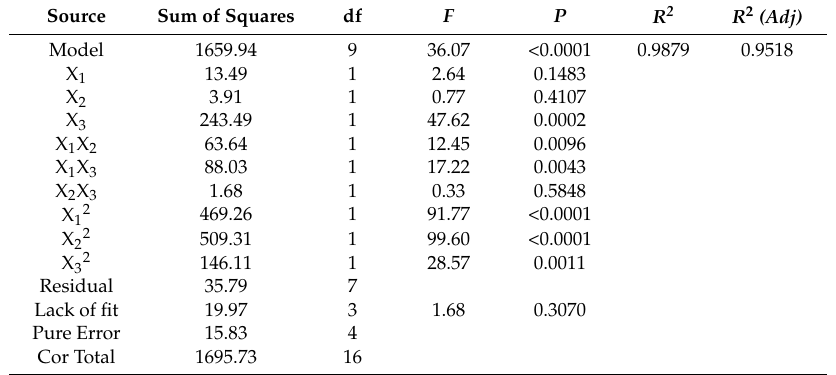
Table 2. ANOVA for the fitted quadratic polynomial model for IC 50 value of antioxidant activity.